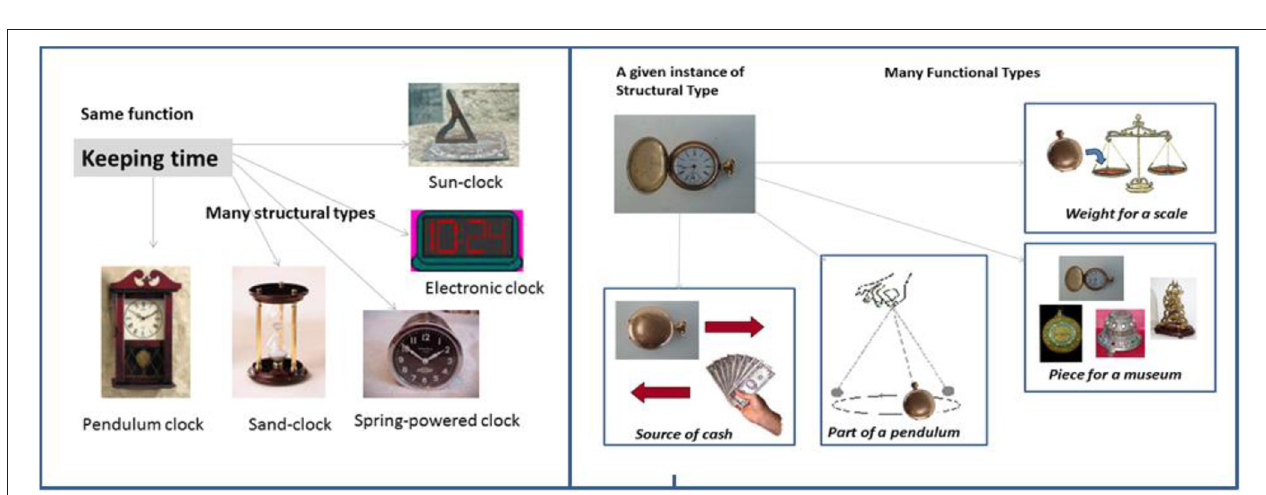
FIGURE 2 | Many-to-one mapping of structural and functional types (adaptation from Giampietro et al., 2006, with permission from Elsevier).